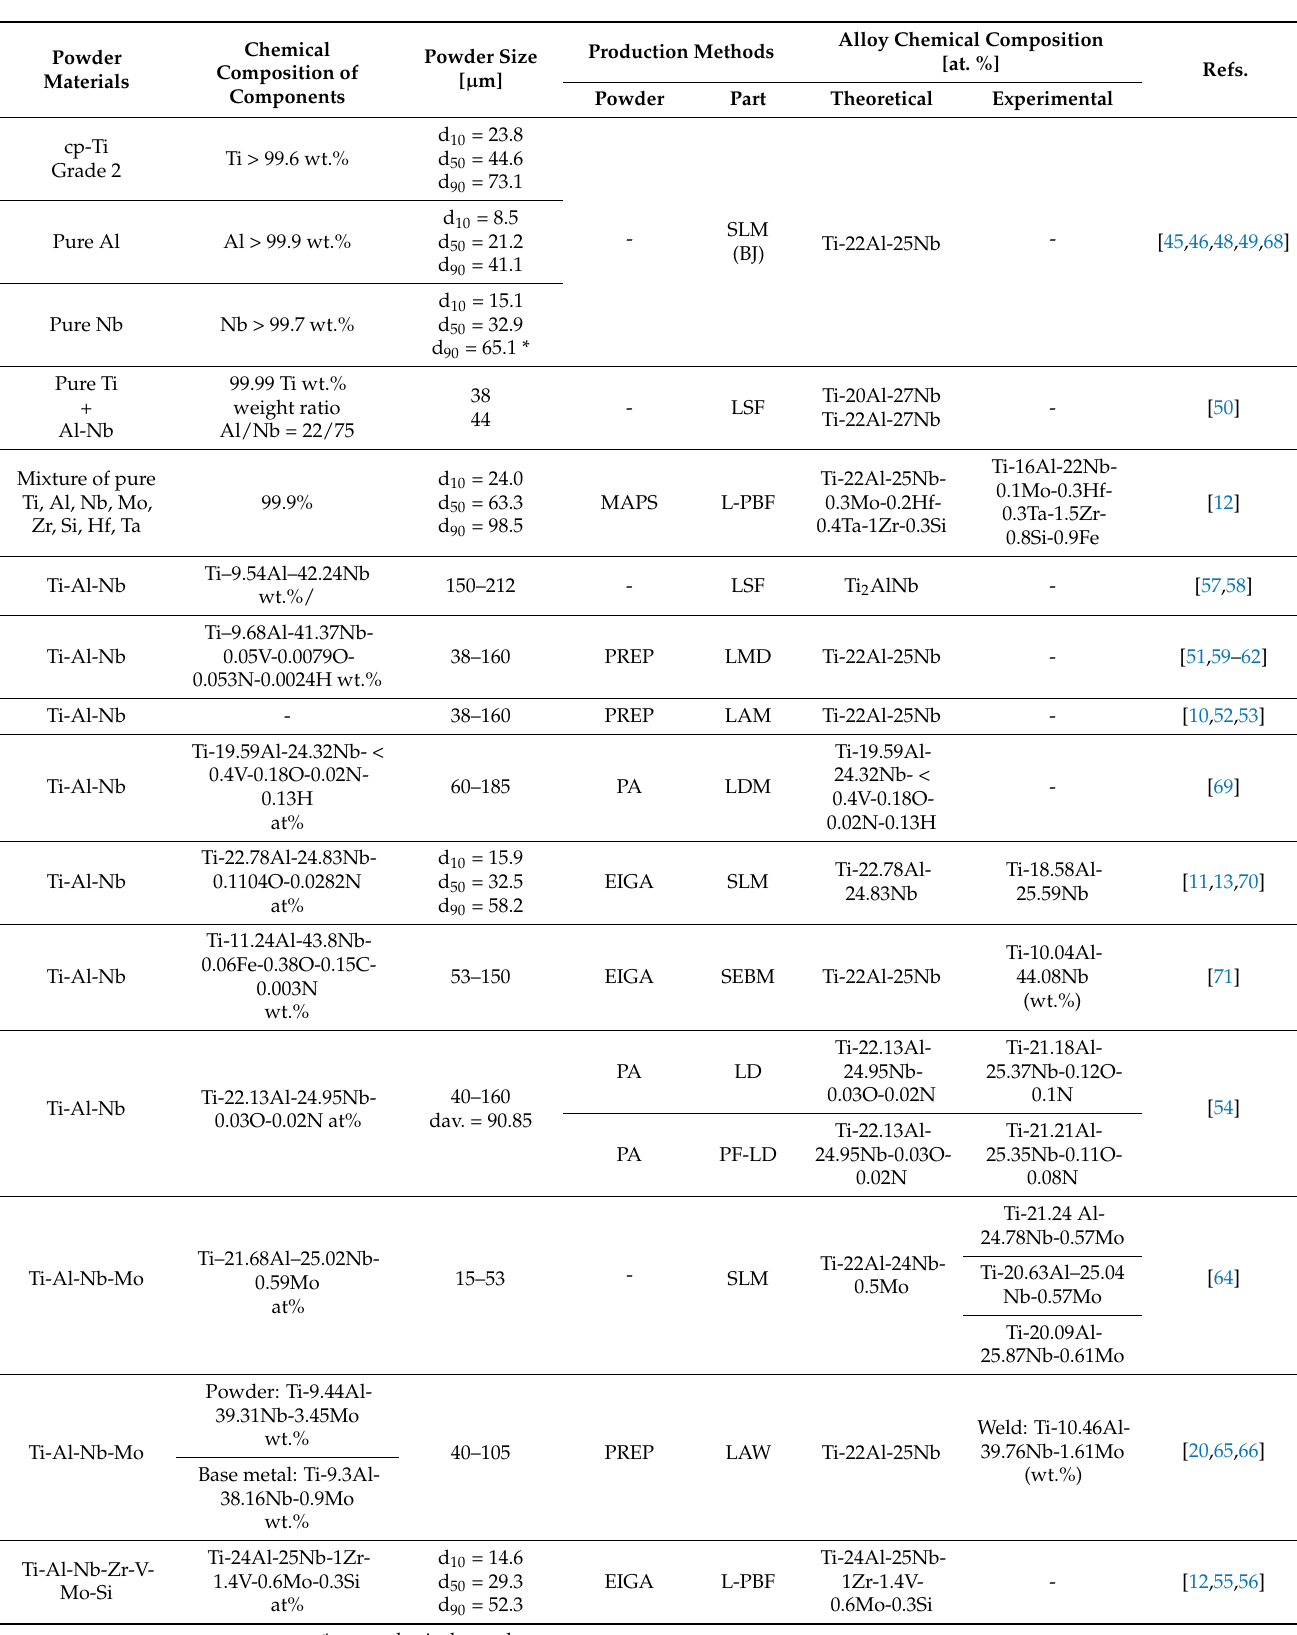
Table 2. Characteristics of the feedstock powders used for AM of Ti 2 AlNb based